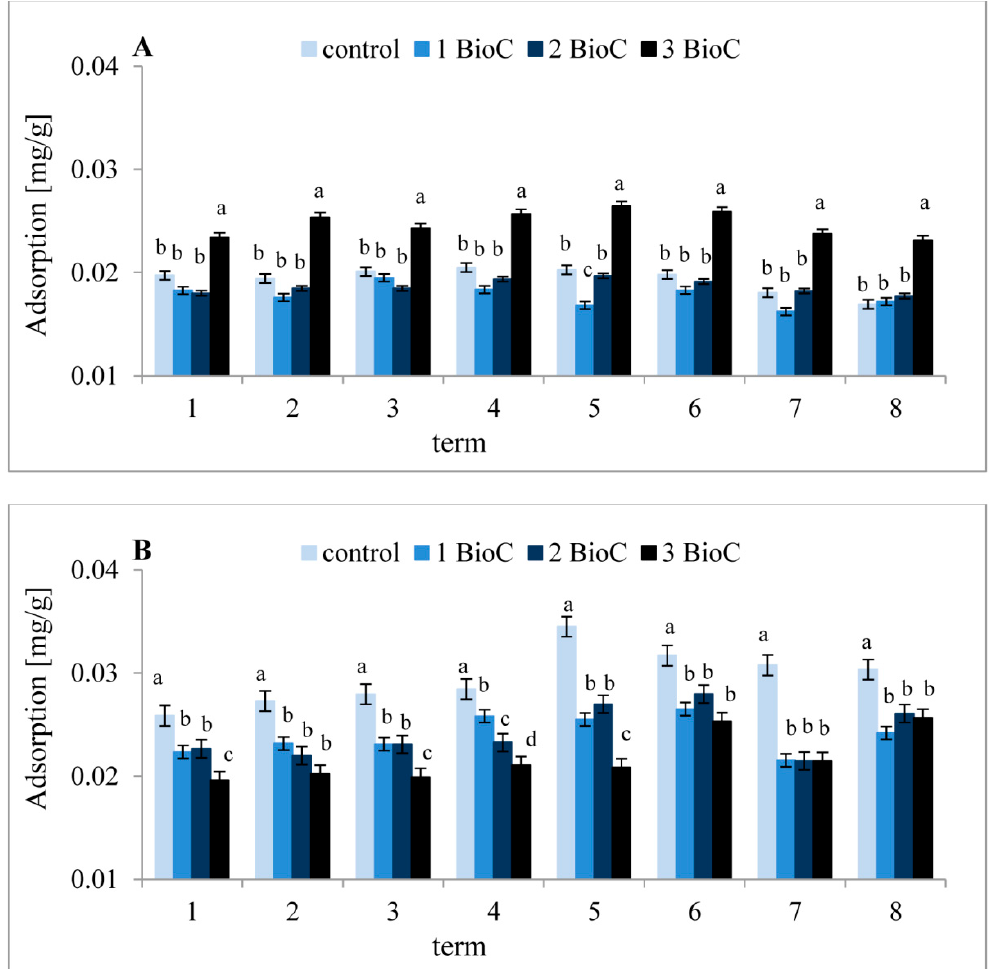
Figure 4. Changes in maximum values of water vapor adsorption in soil samples collected from fallow ( A ) and grassland ( B ) amended with BioC (0, 1, 2, 3 kg · m − 2 BioC) as a function of time (terms: 1 st -8 th ). Average values from three replicates in each term, ± standard deviation. Other letter designations indicate significant differences between values at p < 0.05.